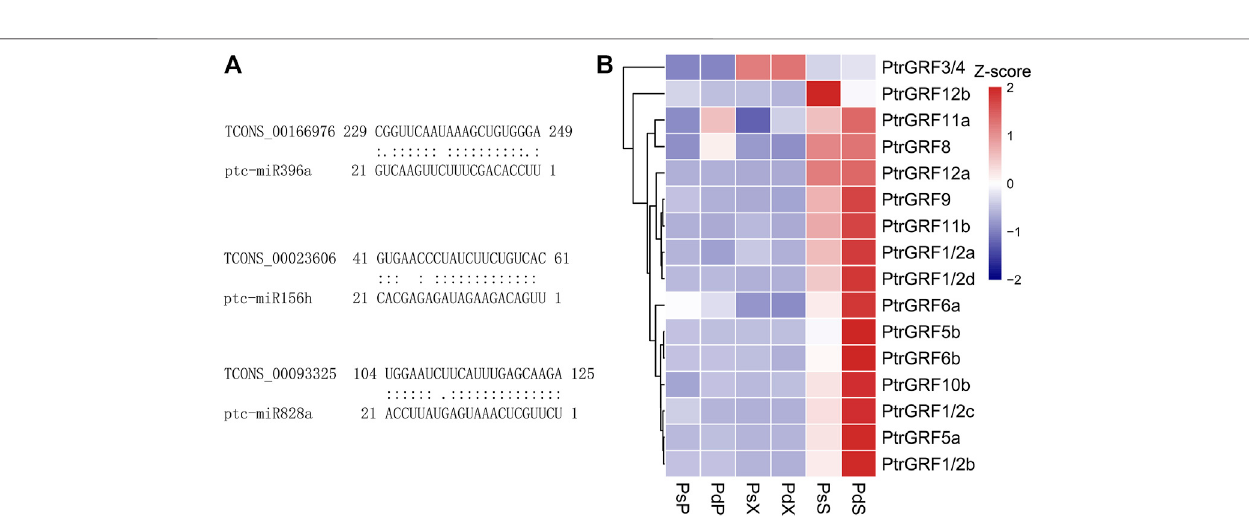
Frontiers in Genetics |